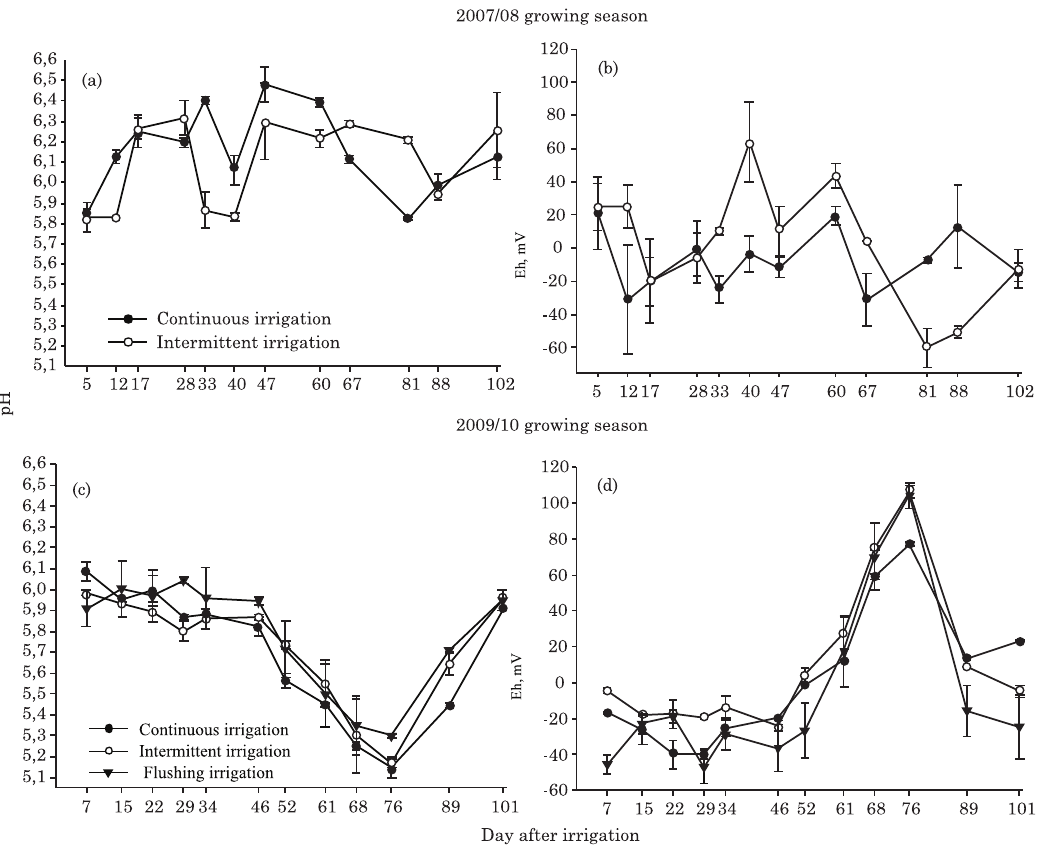
Figure 2. pH values (a) and (c), and Eh values (b) and (d) of the soil solution according to irrigation systems. Vertical lines indicate standard mean deviation.